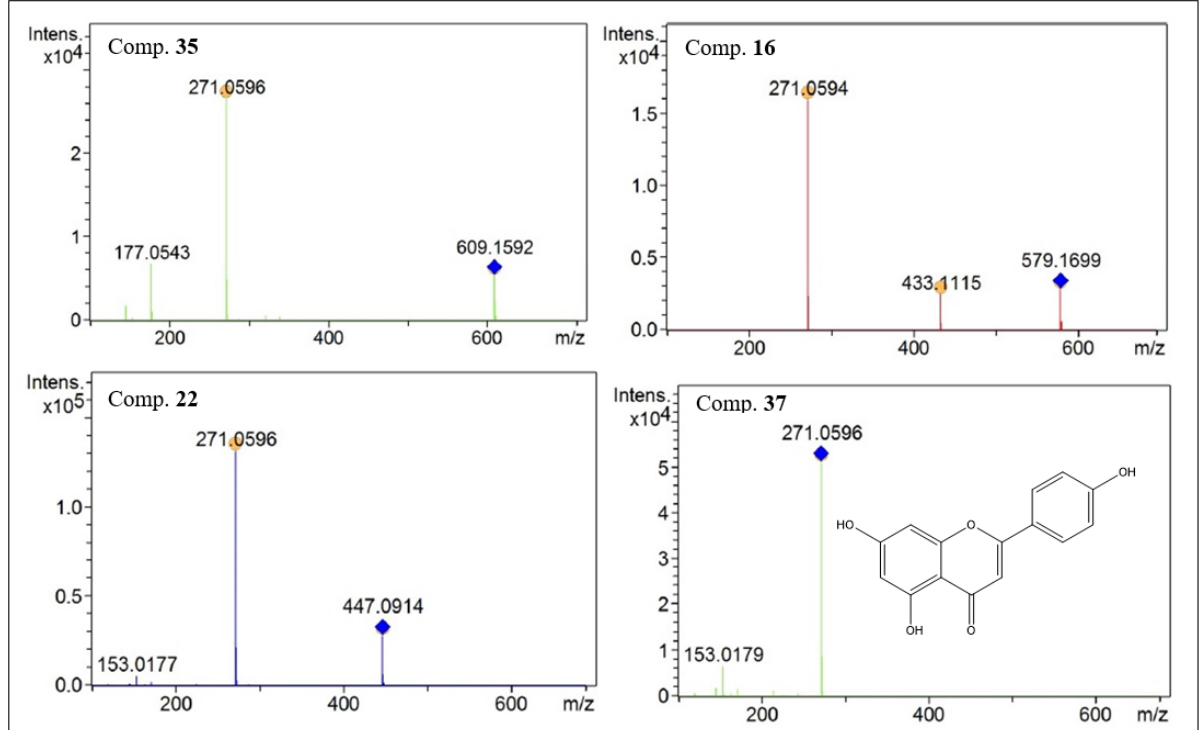
Figure 5. MS 2 spectra of flavone with apigenin-like aglycones present in the ethanolic extract of F. chica leaves.